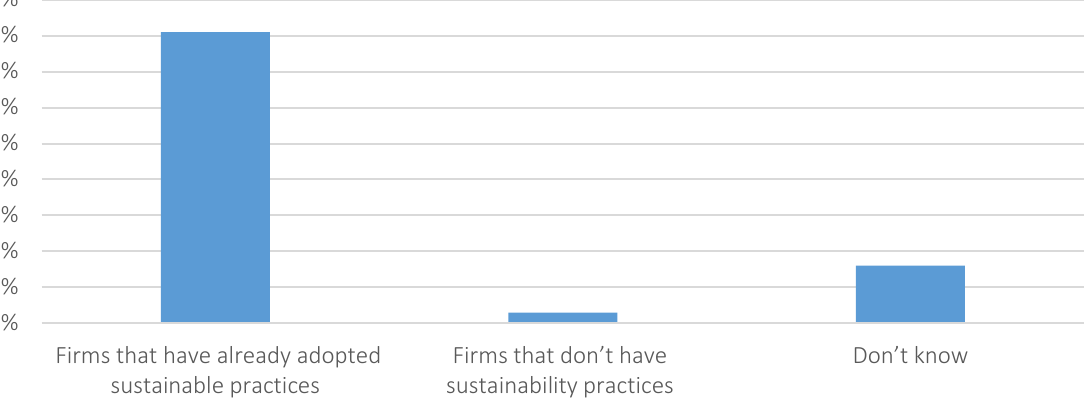
Figure 1. Understanding of sustainability practices in the private sector